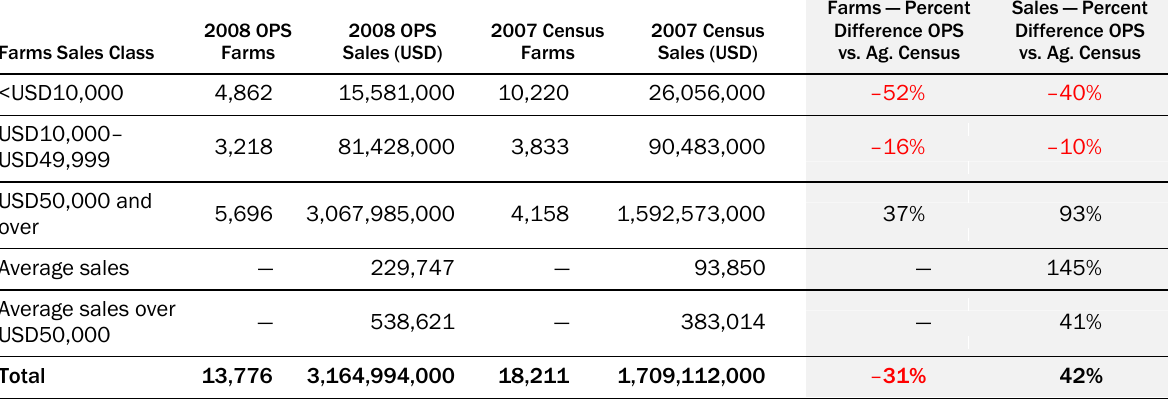
Table 1. Comparison of the 2008 Organic Follow-on Survey Results with 2007 Census of Agriculture Organic Data (Hunt & Matteson,